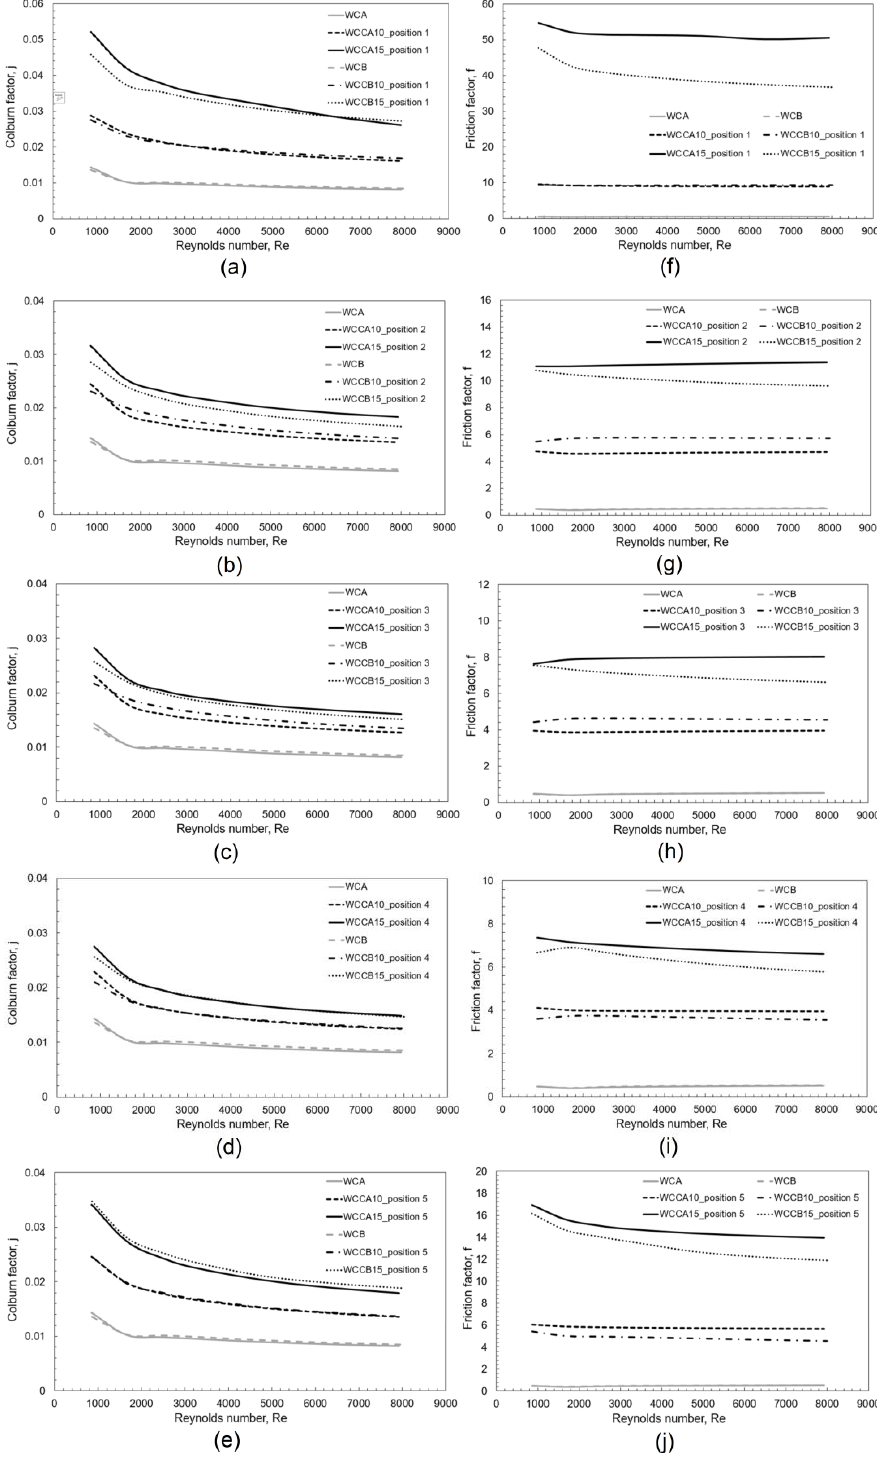
The WCCA15 (position ‘1’) reached 3.64 and 3.84 times higher values of j compared with the WCA and WCB configurations for Re = 857, respectively. The differences in j between the mentioned channels decreased with increased Re . Simultaneously, the fric- tion factor f of the WCA and WCB configurations achieved the minimum values in the range of 0.483 to 0.514 for the WCA and 0.466 to 0.527 for the WCB depending on Re . When changing the CVGs position, the j values decreased to the position ‘4’; however, they increased at the position ‘5’ for the whole range of Re . The values of f were signifi- cantly affected by the CVGs position (Figure 11f – j). For the WCCA15 configuration, CVGs at the position ‘2’ caused a drop in f values in the range of 79.71% to 77.49% compared